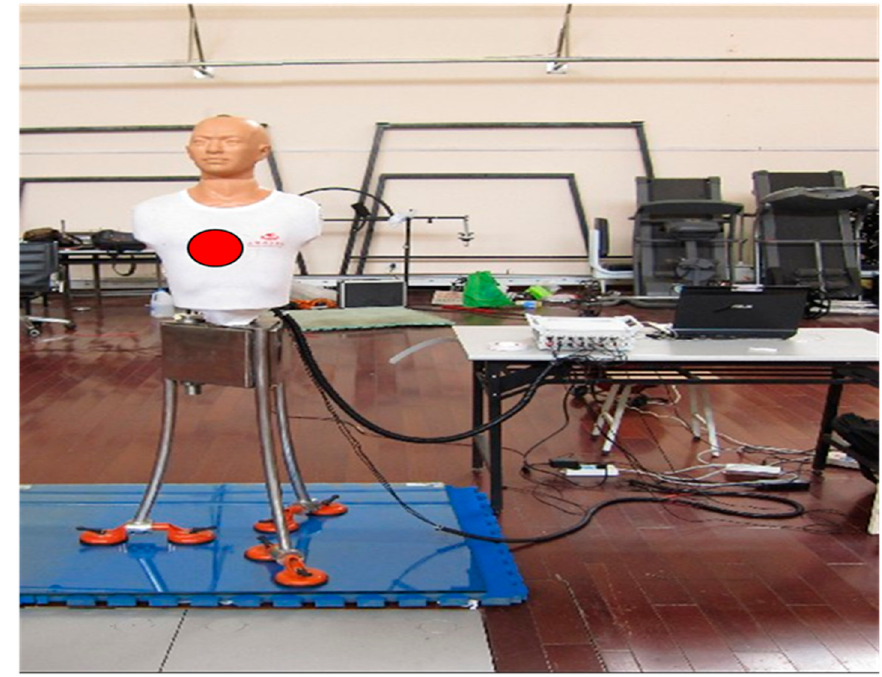
Figure 2. Hit position of the Chinese Kung Fu